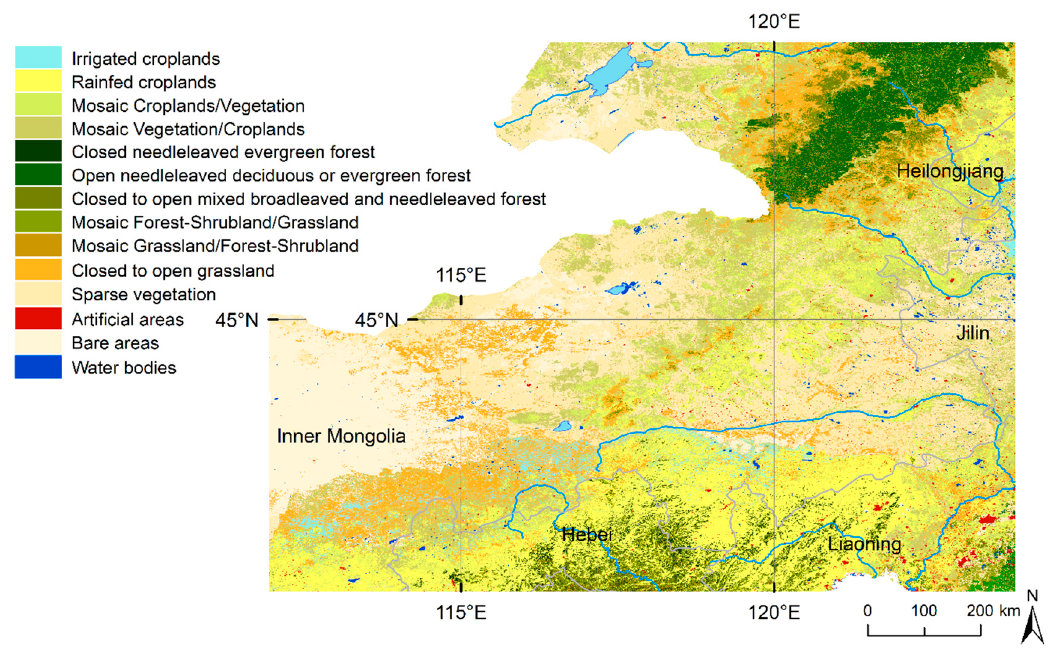
Figure 2. MERIS Land cover map in 2009 (ESA GlobCover Project) of the study region in Northeastern China.